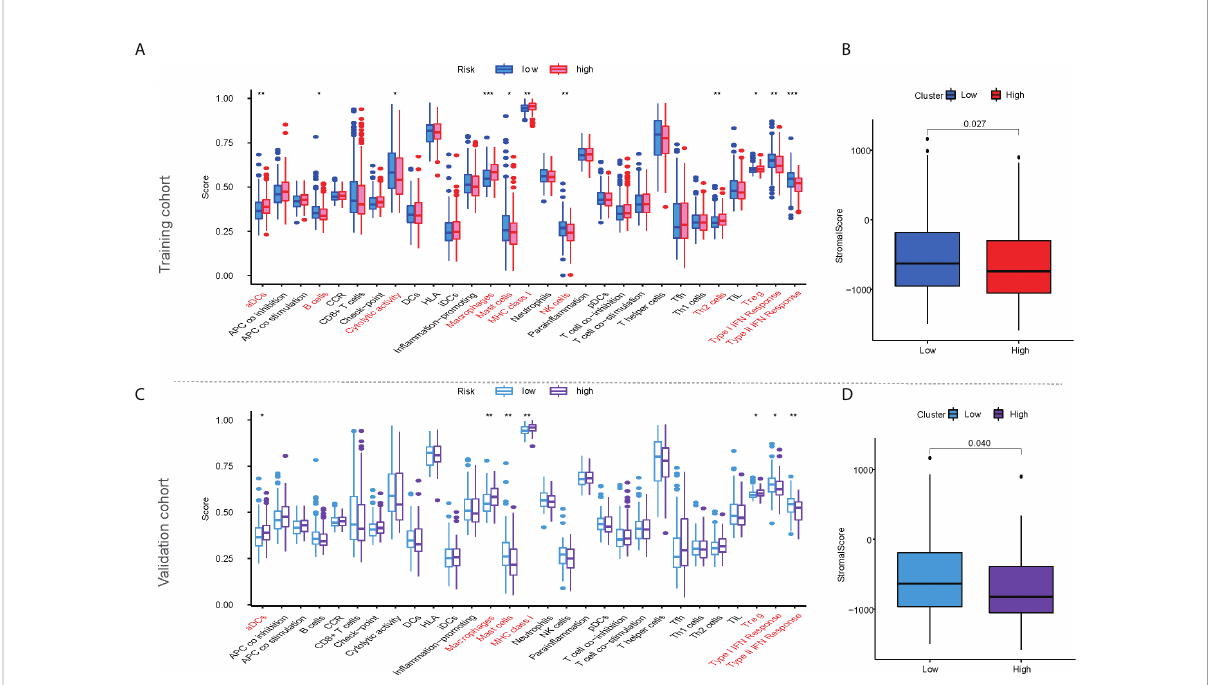
FIGURE 5 The characteristics of immune in fi ltration based on mfrlncRNA signature. (A) Differential analysis of 29 immune signatures according to ssGSEA analysis between high- and low-risk populations in the training cohort. (B) Differential analysis of stromal scores according to ESTIMATE analysis between high- and low-risk populations in the training cohort. (C, D) The characteristics of immune in fi ltration based on mfrlncRNA signature in the validation cohort. The asterisks represented the statistical p -value ( p > 0.05; * p < 0.05; ** p < 0.01; *** p < 0.001). ssGSEA, single-sample gene-set enrichment analysis; ESTIMATE, Estimation of STromal and Immune cells in MAlignant Tumour tissues using Expression